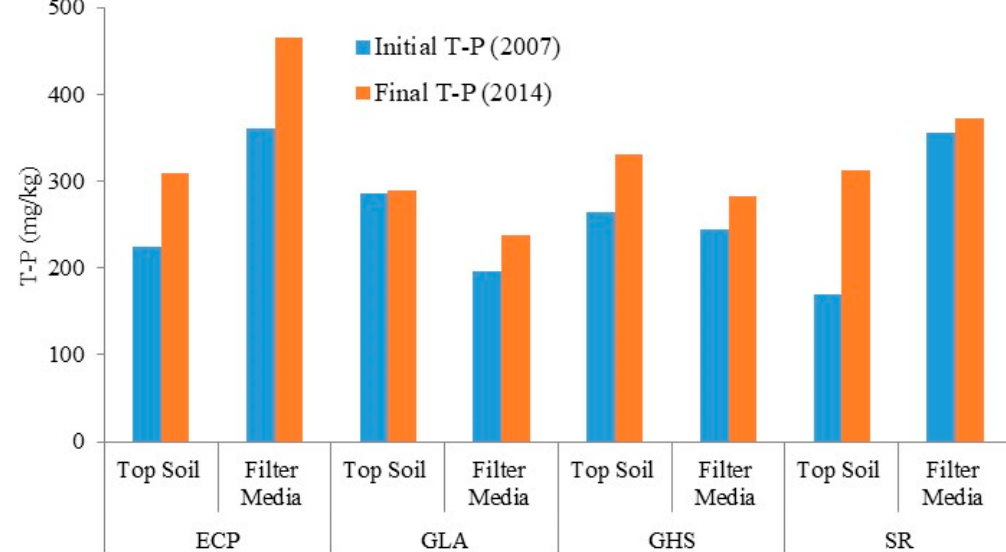
Figure 12. T-P mass concentrations in top soil and filter media in 2007 and 2014. Table 6. Phosphorus concentration and standard deviation by extraction method and significance level of linear reduction with depth after seven years of operation ( p ).